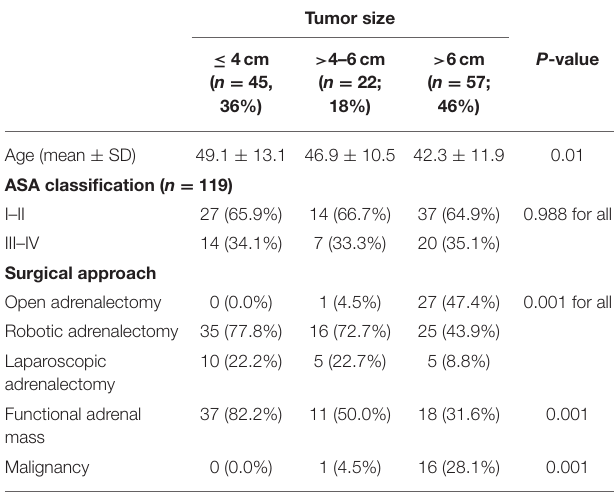
TABLE 3 | Clinical characteristics and surgical approach based on tumor